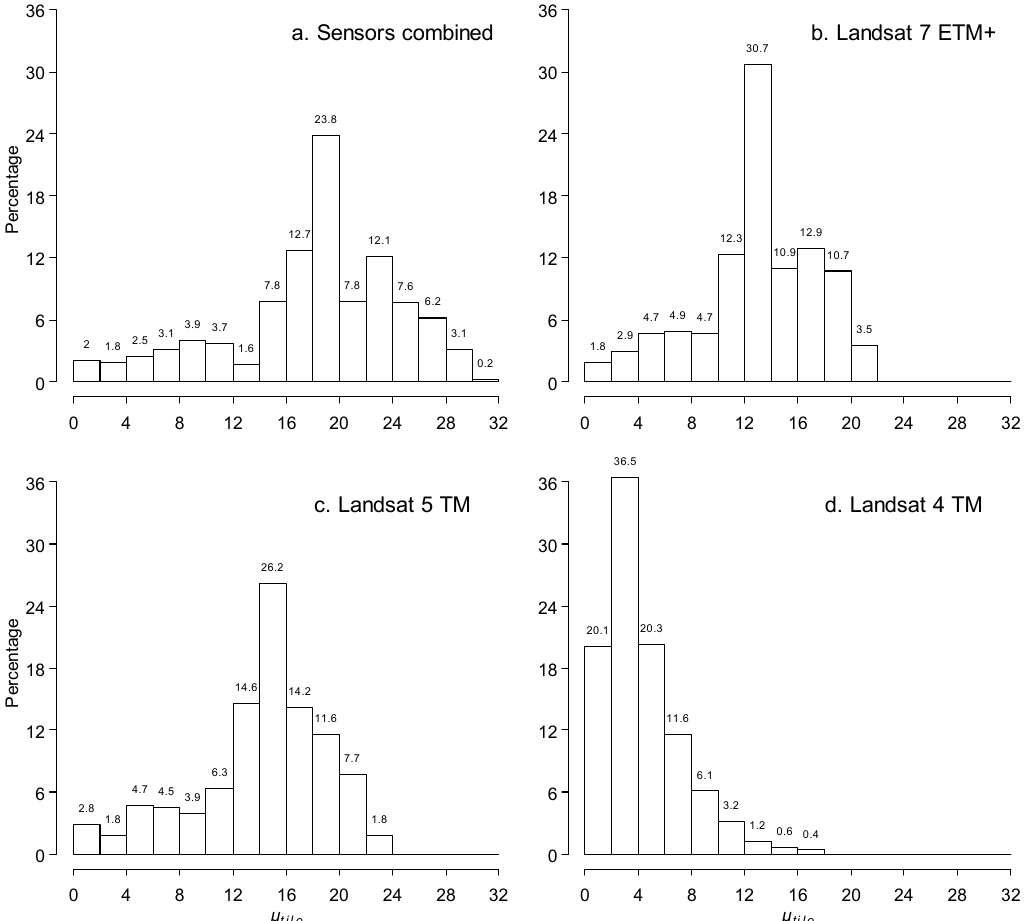
Figure 10. CONUS histograms of the average annual number ( µ tile , Equation (3)) of non-fill non-cloudy observations across each ARD tile for the 36 year study period, for ( a ) Landsat 4 TM, 5 TM and 7 ETM+ combined, ( b ) Landsat 7 ETM+, ( c ) Landsat 5 TM, ( d ) Landsat 4 TM. The histogram bins are defined as <2, 2 – <4, 4 – <6, …, 30 - <32. All results derived from the Figure 9 data. The ten CONUS ARD tiles with the highest 𝜇 (cid:3047)(cid:3036)(cid:3039)(cid:3032) values are summarized in Table 2 and highlighted in Figure 9. The tiles are clustered over the south-west and with the exception of Landsat 4 TM, have 𝜇 (cid:3047)(cid:3036)(cid:3039)(cid:3032) > 20. Considering Landsat 7 ETM+, Landsat 5 TM and the three sensors combined, eight of the ten most frequency observed ARD tiles are common. Southern California ARD tiles h05v13 (centered 33°06'56.45"N, 114°53'38.52"W) and h04v11 (centered 35°27'32.82"N, 117°11'13.44"W) have the highest 𝜇 (cid:3047)(cid:3036)(cid:3039)(cid:3032) values for these sensors. The top ten Landsat 4 TM ARD tiles have a different geographic distribution compared to the other sensors, due to the spatially irregular number of observations (Figure 6). Southern Arizona ARD tile h06v13 (centered 33°22'12.09"N, 113°18'11.39"W) has the highest 𝜇 (cid:3047)(cid:3036)(cid:3039)(cid:3032) value for the Landsat 4 TM. Table 2. The ten most observed CONUS cloud-free ARD tiles over the 36 year study period (red outlined in Figure 9).